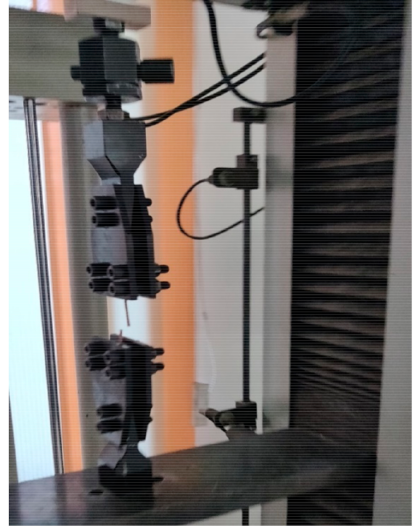
Figure 4. Universal testing